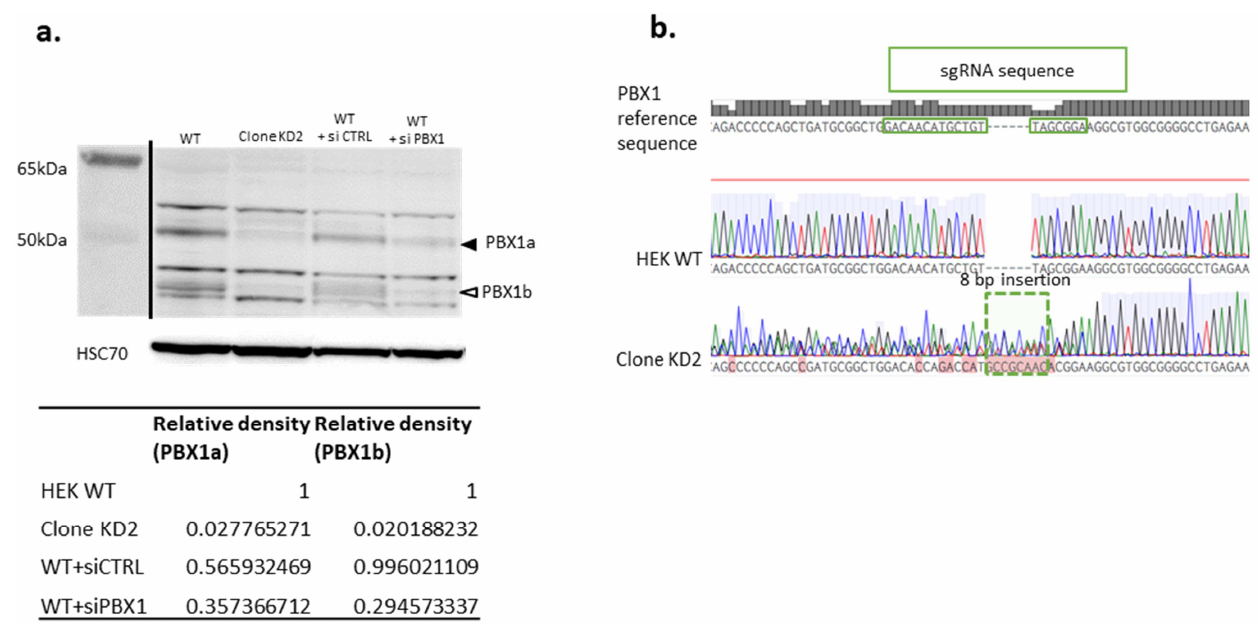
Figure 3. Obtention of a PBX1 KD clone. Panel ( a ): Western Blot demonstrating the diminution of both PBX1a (black arrowhead) and PBX1b (white arrowhead) expression PBX1 KD clone (clone KD2). WT HEK cells transfected with control siRNA (WT + si CTRL) or PBX1 siRNA (WT + si PBX1) served as negative and positive controls, respectively. WT: non-transfected HEK cells. Panel ( b ): Sequence of PBX1 exon 3 in WT HEK cells (HEK WT) and PBX1 KD clone (clone KD2) showing an 8-bp insertion (dashed box) at the sgRNA’s target sequence (green box) in KD2. Uncropped Western Blot is presented in Supplemental Data (Figure S10).